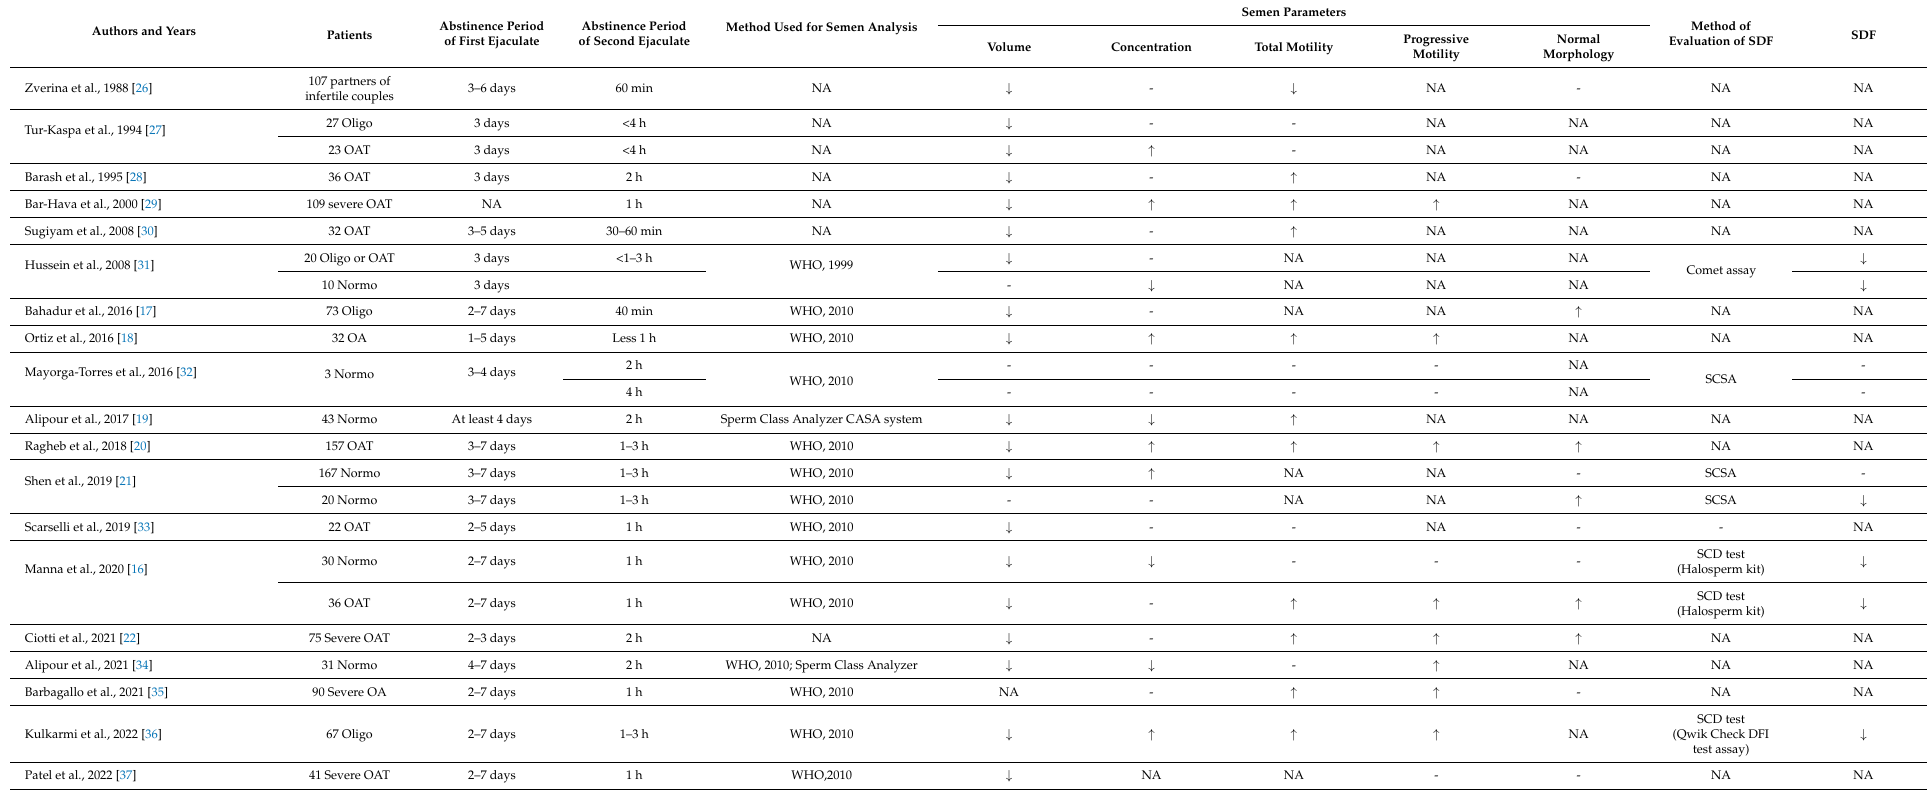
Table 3. Effects of a very short abstinence period (within 4 h) on sperm conventional parameters and DNA fragmentation